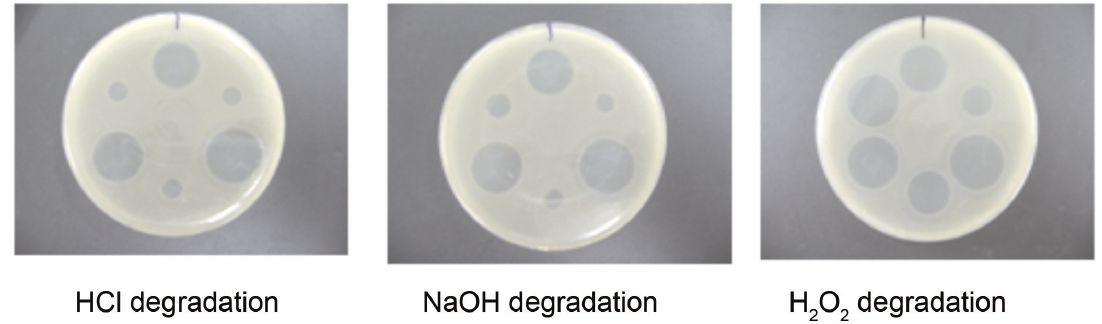
FIGURE 5 - Zone diameters for the azithromycin under different chemical conditions of degradation studies (acid, alkaline and hydrogen peroxide